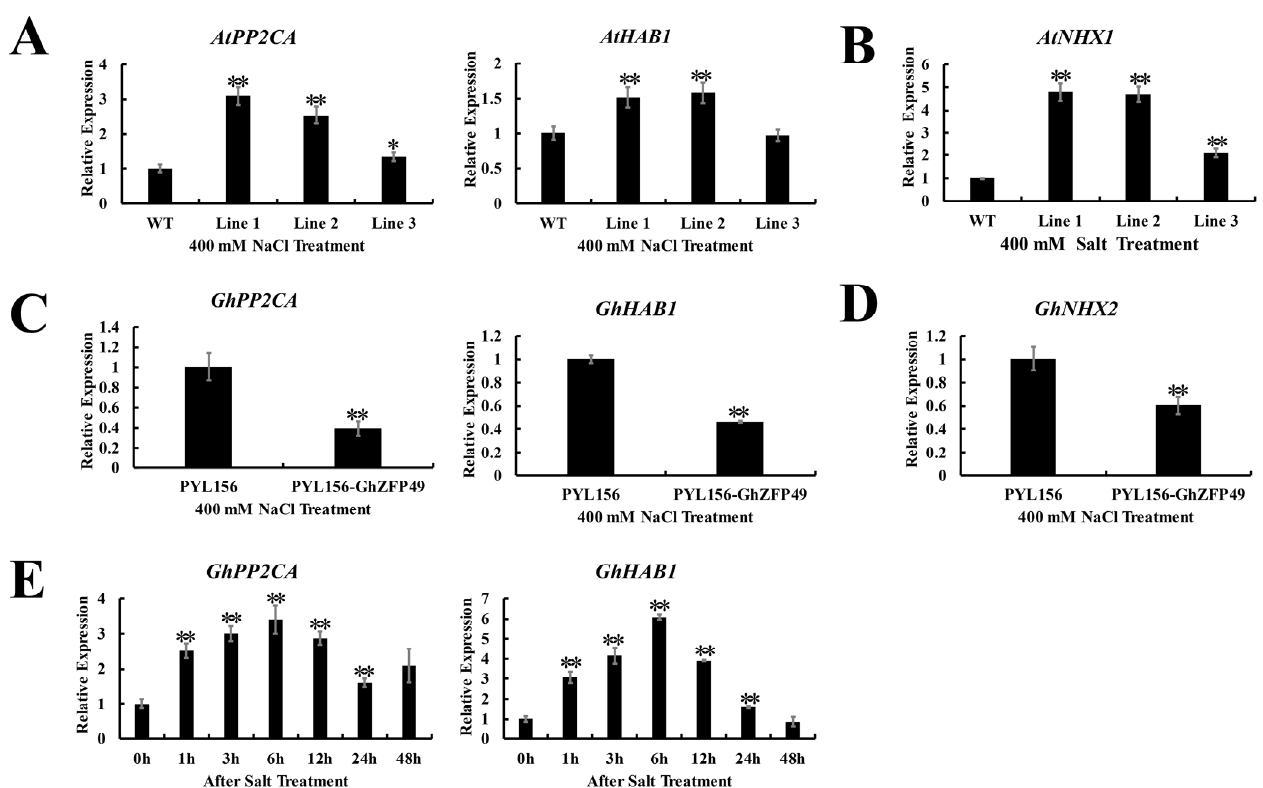
Figure 8. The expression levels of genes related to ABA and osmotic stress in cotton and Arabidopsis under 400 mM NaCl treatment. ( A ) The expression levels of ABA marker genes ( AtPP2CA and AtHAB1 ) in WT Arabidopsis and three transgenic Arabidopsis lines in leaves under 400 mM NaCl treatment. ( B ) The relative expression of the osmotic stress marker gene ( AtNHX1 ) in WT Arabidopsis and three transgenic Arabidopsis lines in leaves under 400 mM NaCl treatment. ( C ) The relative ex- pression of ABA marker genes ( GhPP2CA and GhHAB1 ) in control plants (plants injected with pYL156 empty vector) and silenced plants (plants injected with pYL156- GhC3H20 vector) in leaves under 400 mM NaCl treatment. ( D ) The relative expression of the osmotic stress marker gene ( GhNHX2 ) in control plants (plants injected with pYL156 empty vector) and silenced plants (plants injected with pYL156- GhC3H20 vector) in leaves under 400 mM NaCl treatment. ( E ) The expression